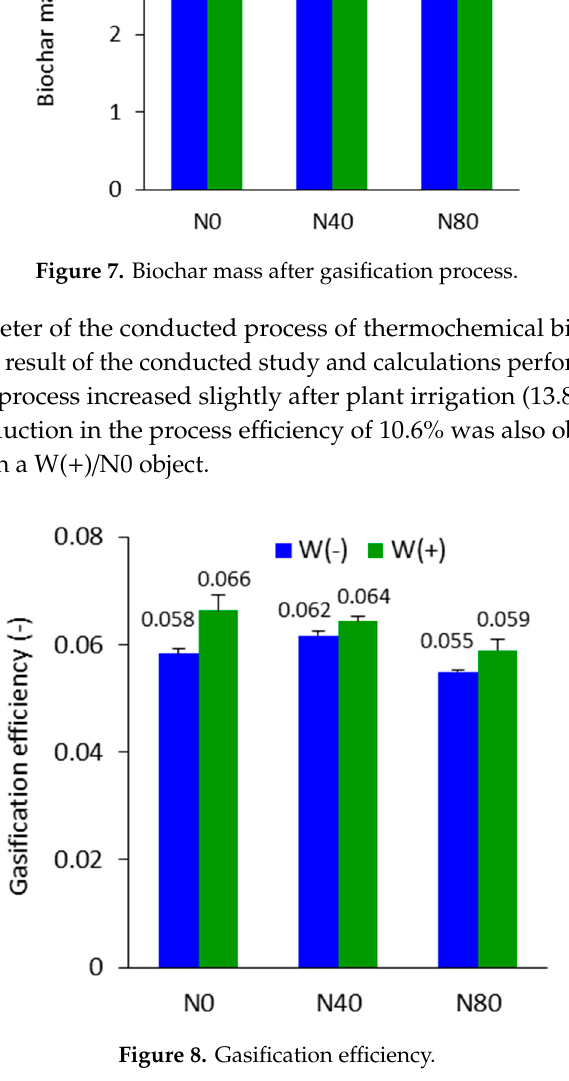
Figure 7. Biochar mass after gasification process.